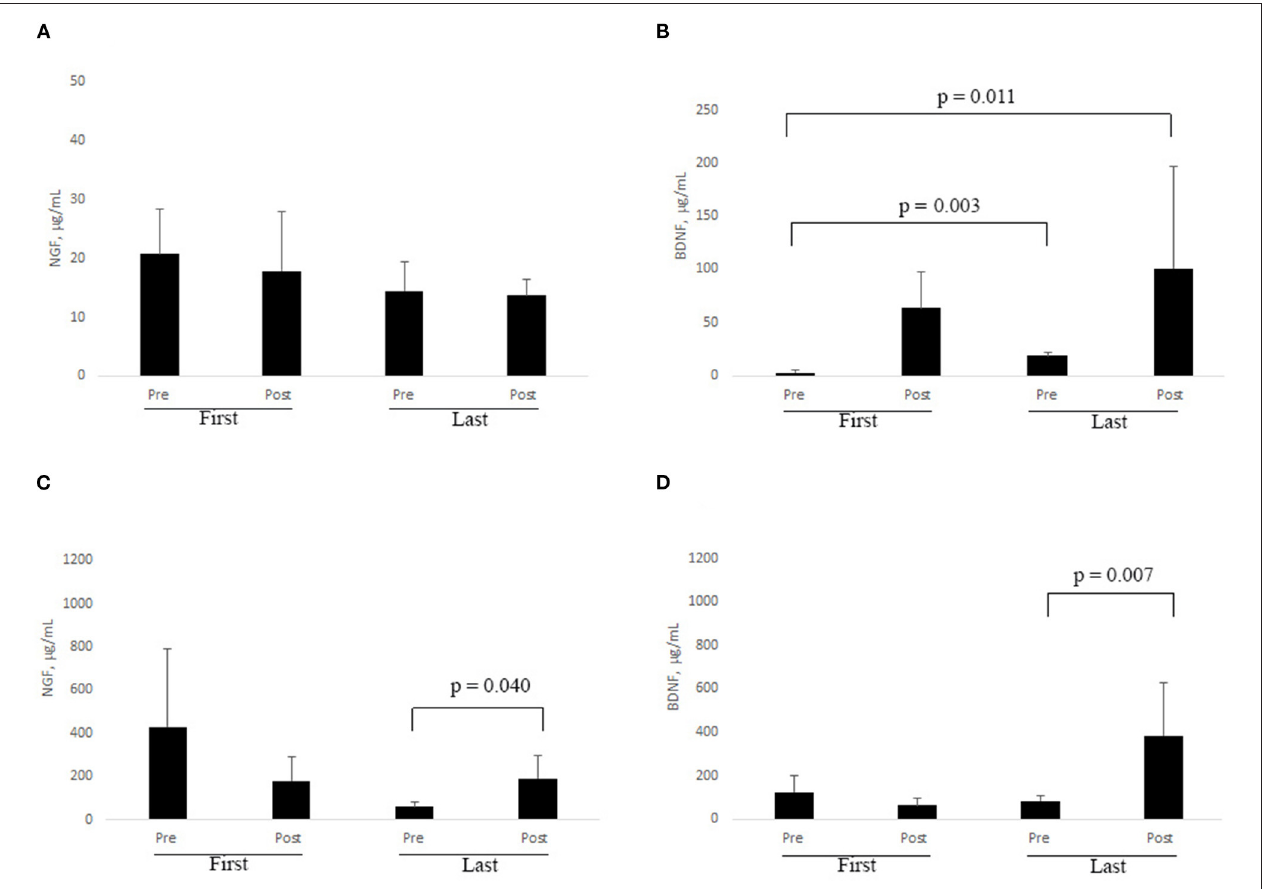
FIGURE 3 | (A–D) . RR training influences NGF and BDNF levels in biological fluids. At each session of RR training, subjects were asked to provide saliva and tear samples by self-sampling (see Methods). ELISA results are shown for NGF in saliva (A) and tears (C) , and for BDNF in saliva (B) and tears (D) , respectively. Significant changes are indicated by p ≤ 0.05 (Non-parametric analysis: Wilcoxon test).